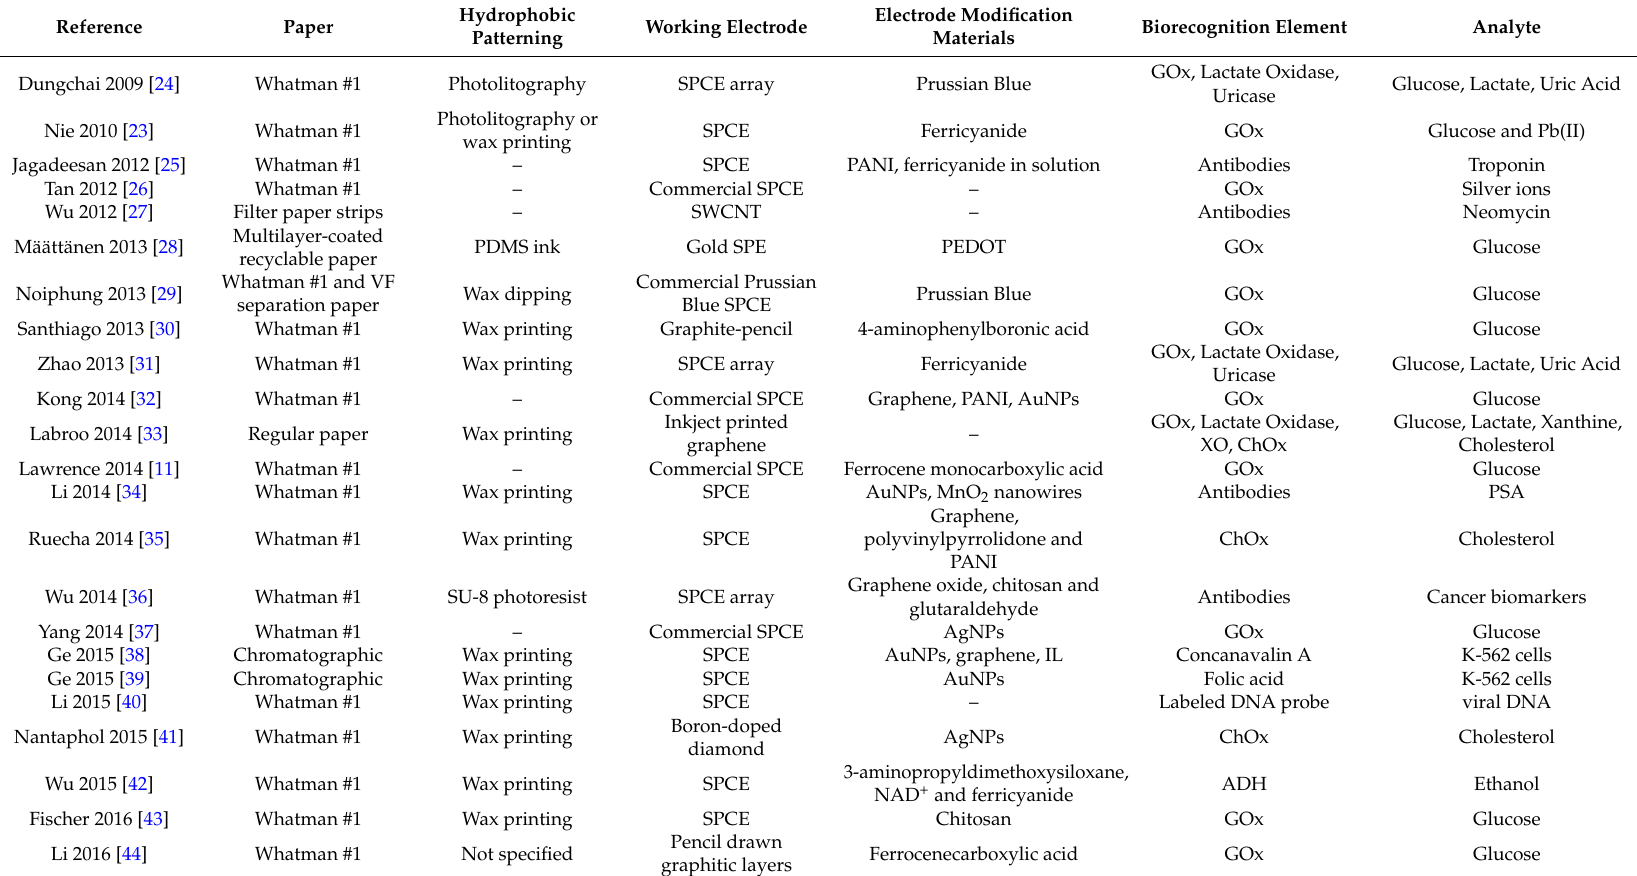
Table 1. Characteristics of paper-based electrochemical